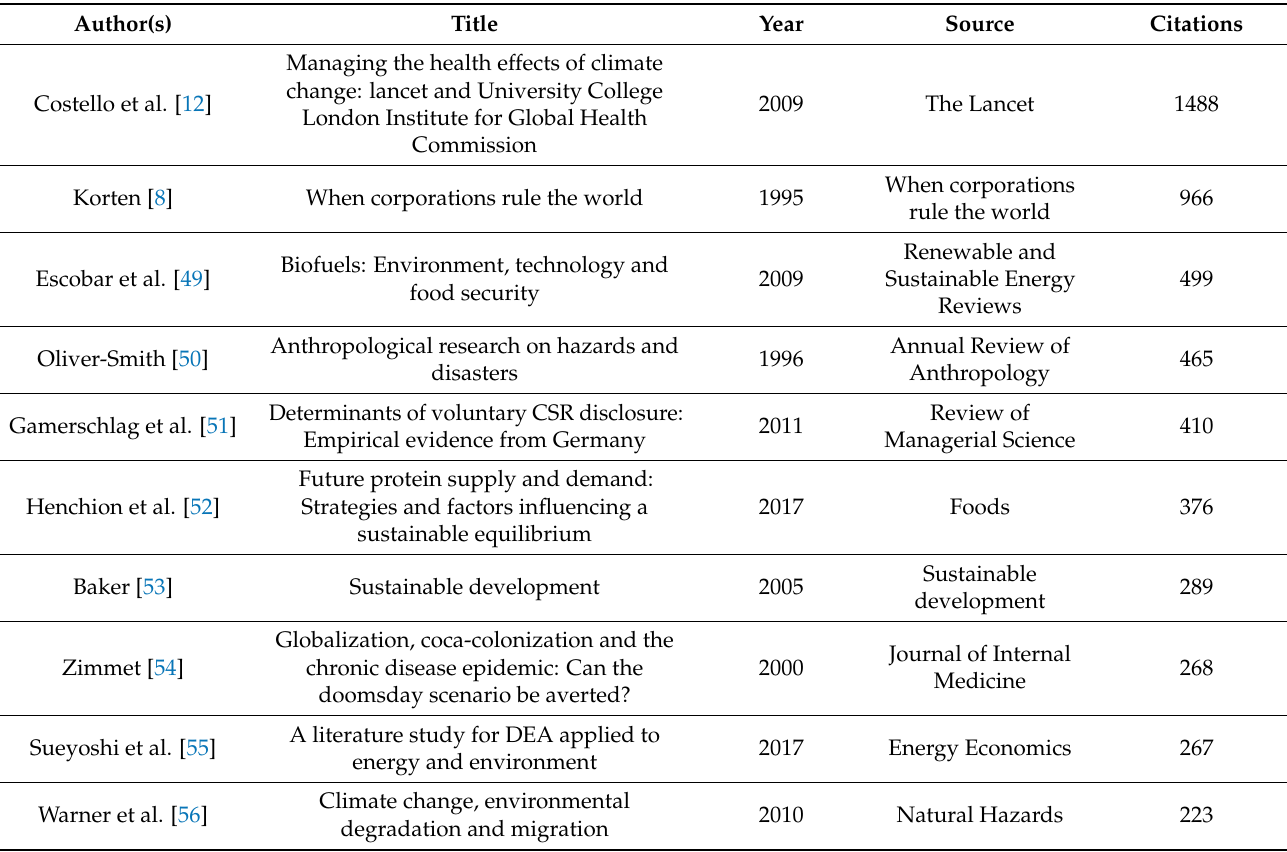
Table 6. Top 10 most frequently cited publications.